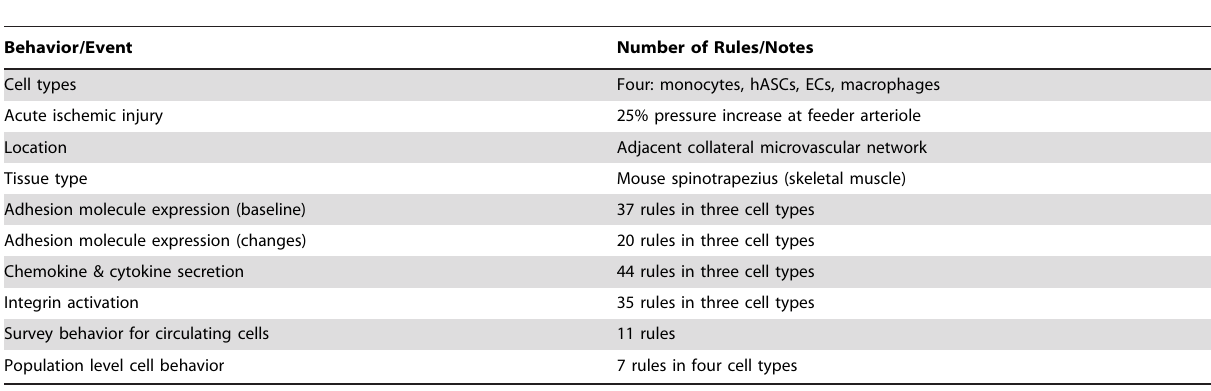
Table 5. Summary and scope of computational